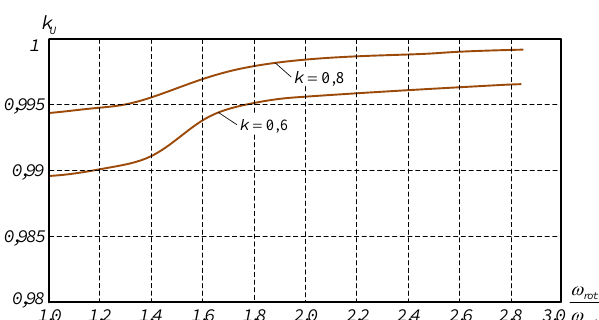
Figure 7. Functional dependence of distortion factor of output voltage on ratio of rotational speed of generator to output voltage frequency of MCVS with open control system of CC